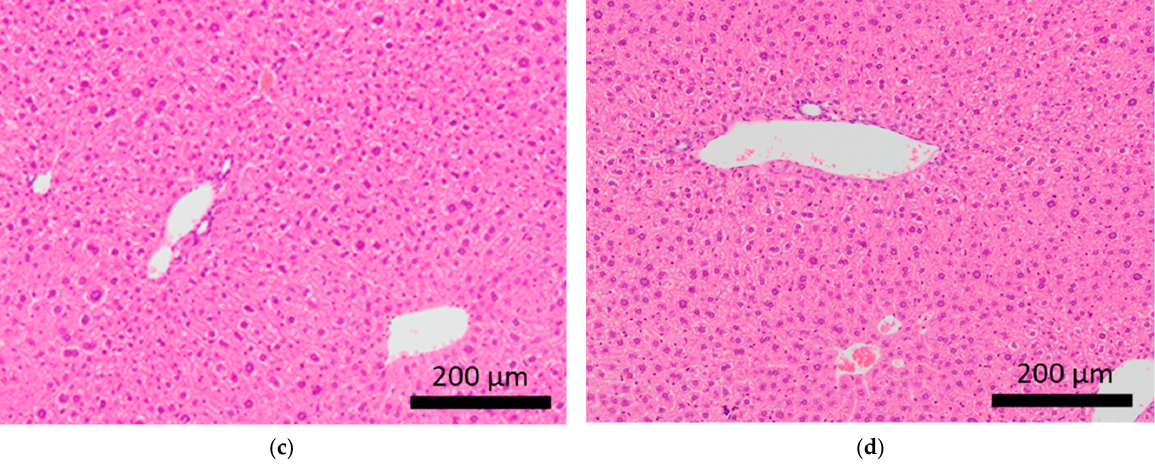
Figure 3. Histopathological features of the livers of BALB/c mice. Arrows indicate focal necrosis in the livers of control mice ( a,b ), whereas this was not observed in mice subjected to sCSDS ( c,d ).